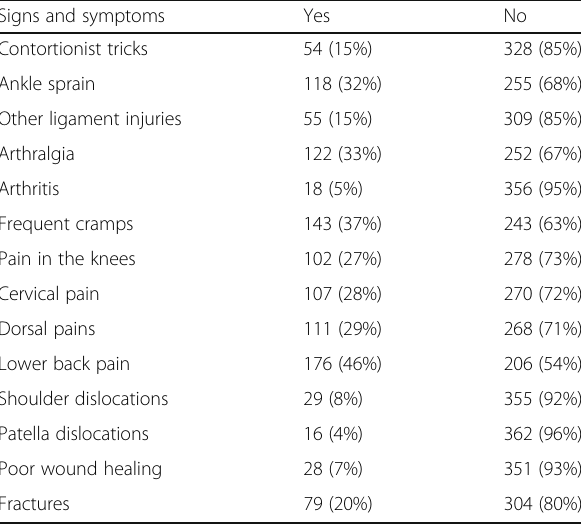
Table 2 Frequencies of valid responses in the inquiry of signs and symptoms, musculoskeletal and systemic, related to joint hypermobility